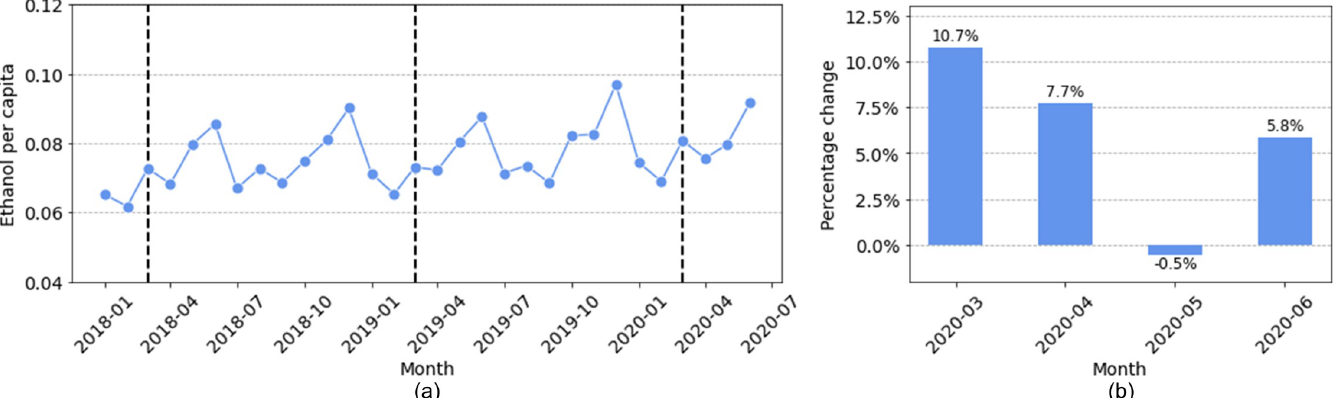
Fig 2. Total spirits sales in 13 states: (a) sales in ethanol per capita from January 2018 to June 2020 (the dashed lines indicate the month of March in 2018, 2019, and 2020); (b) sales changes in March, April, May, and June 2020 as compared with the average sales in the same months during 2018 and 2019.